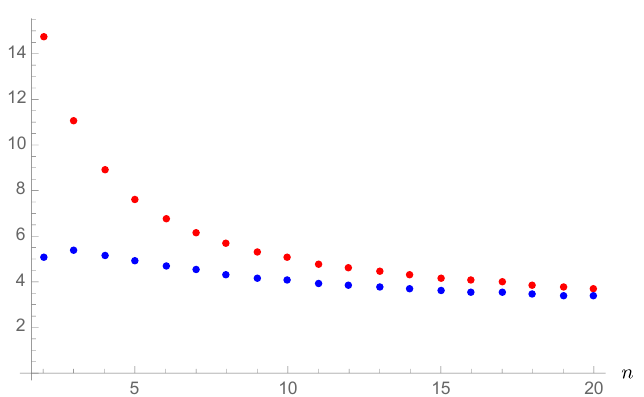
Figure 9 . The original volume conjecture sequence (left hand side of (1.1), blue) for the figure- eight knot, and the modified sequence (left hand side of (5.3), red). The non-monotonicity at the beginning of the original sequence is repaired by (5.3). Both sequences are computed using Habiro’s formula for the colored Jones polynomial of the figure-eight knot